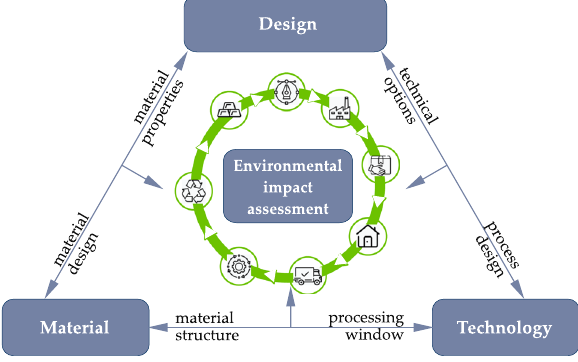
Fig. 3 Product life cycle (center) and the fields of action to achieve Neutral Lightweight